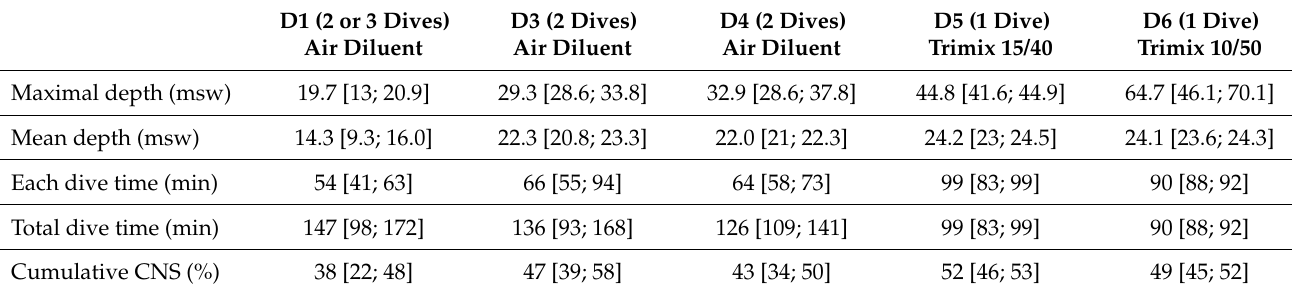
Table 2. Diving description during the monitoring week. The third dive on the first day were performed by 5 divers to test equipment. Cumulative central nervous system oxygen toxicity (CNS) represents the time spent at a given oxygen partial pressure (PpO 2 ) and dividing by the NOAA time limit for that PpO 2 (corresponding to the cumulative oxygen